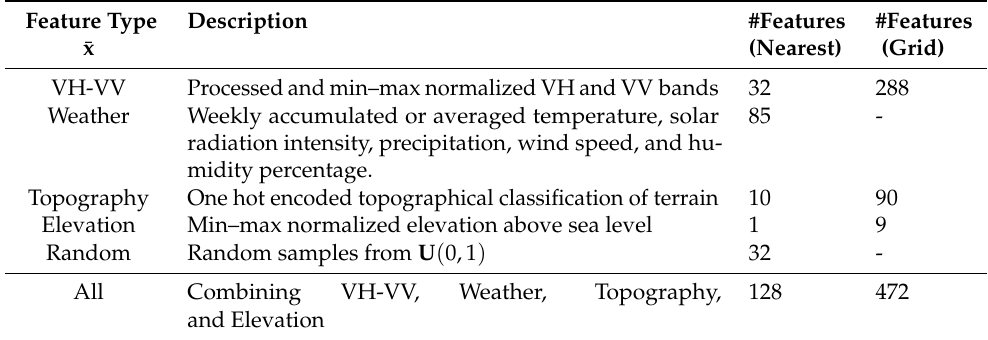
Table 2. List of different features used in this study and their sizes. Also, note that a random feature is included as a control to uncover a baseline for comparisons.